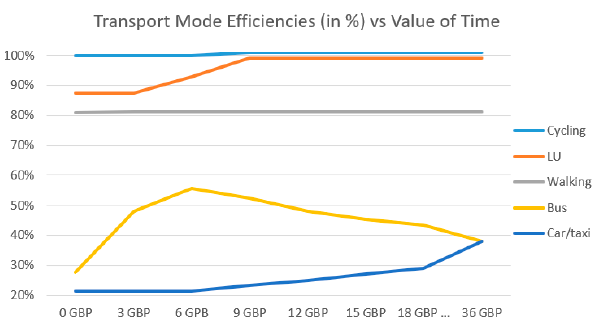
Figure 17. Route D: Impact of the value of time in the efficiency of the transport modes efficiency.